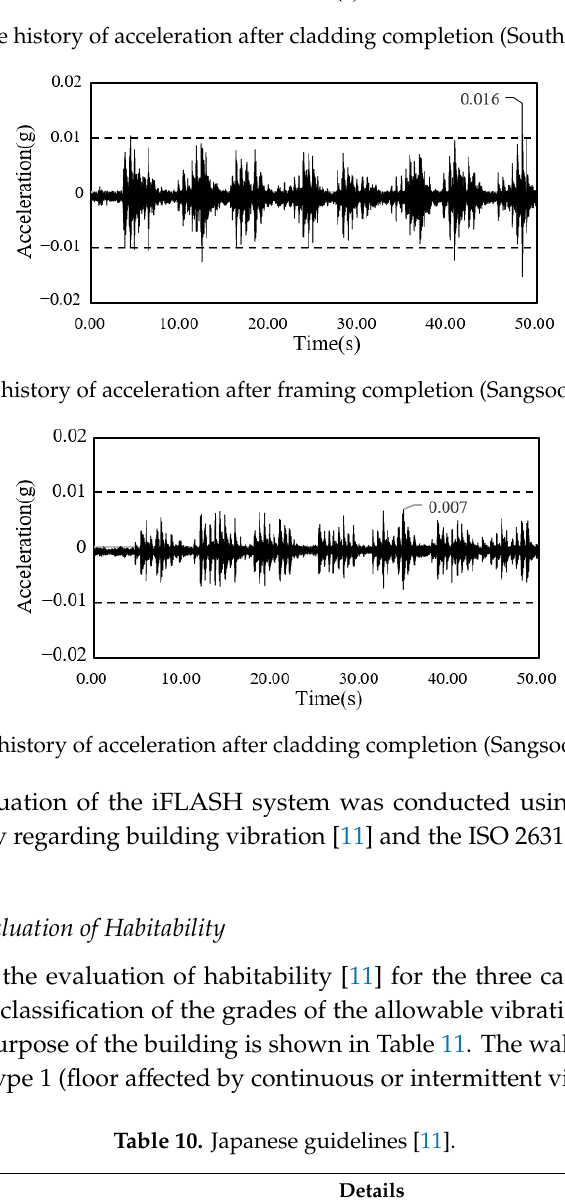
Table 10. Japanese guidelines [11].